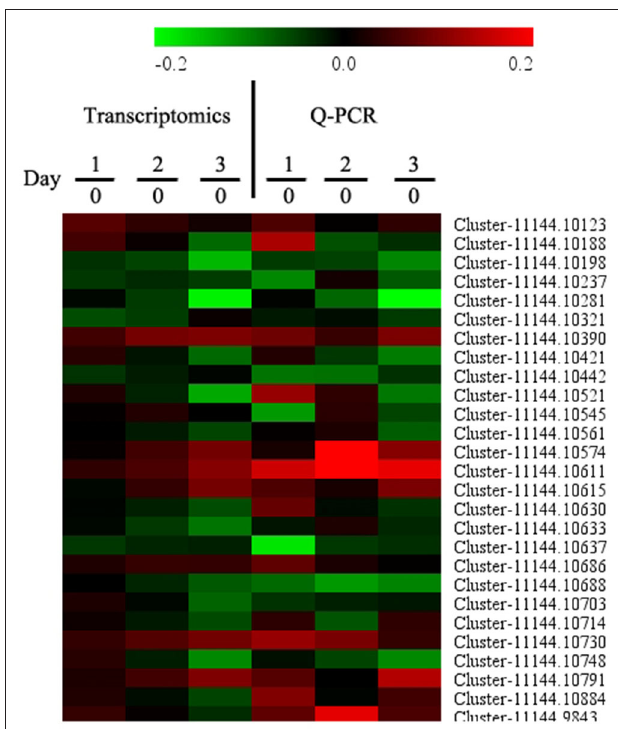
FIGURE 4 | Quantitative real-time PCR (qRT-PCR) analysis of a set of DEGs. Samples on days 0, 1, 2, and 3 were used for Q-PCR conformation experiment. Gene expression on day 0 was set as 1, and the relative expression level was calculated for tested genes. Each data point represents a mean ( n =